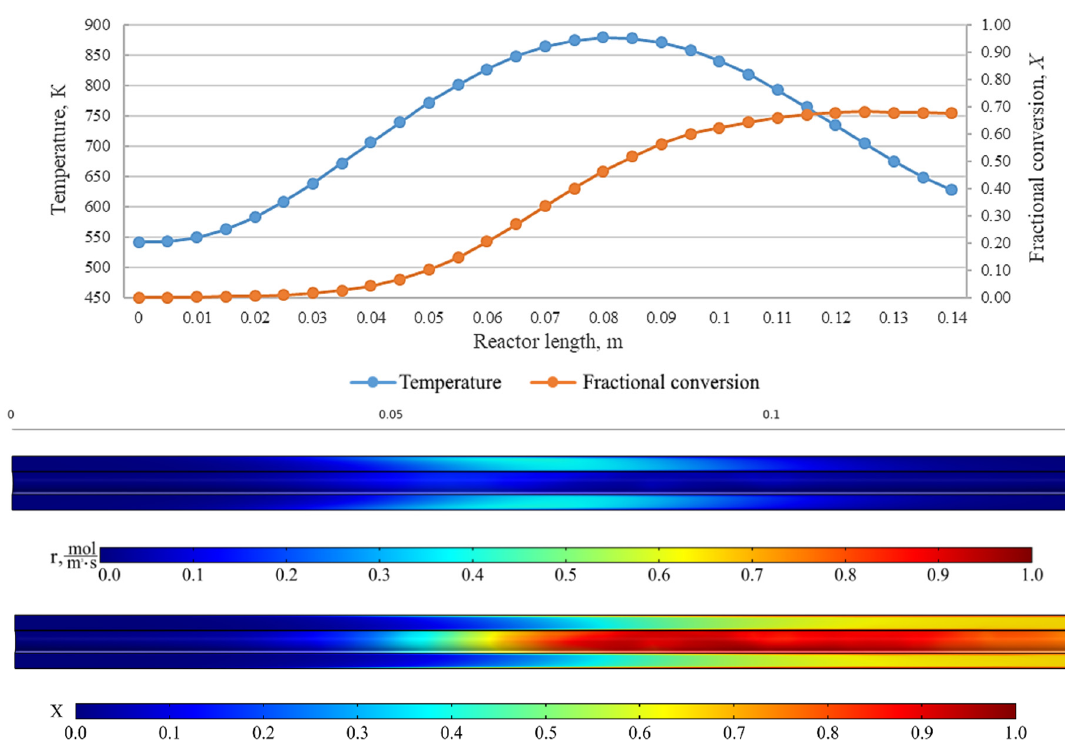
Figure 13. From top to bottom: temperature and fractional conversion curves, profiles of the reaction rate and fractional conversion along the reactor length for the experiment BnOm_600_37 (Tmax = 600 °С , 𝑉(cid:4662) = 3.0 L/min).